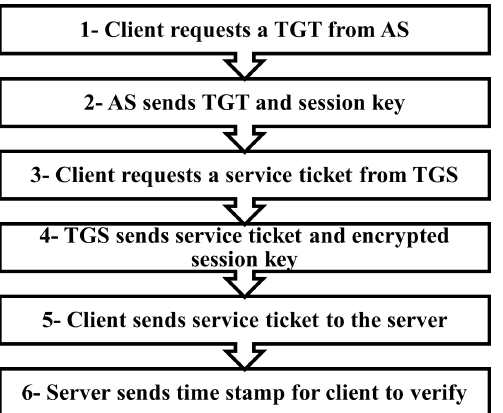
Figure 1. Kerberos Authentication Workflow. Adapted with permission from Ref.